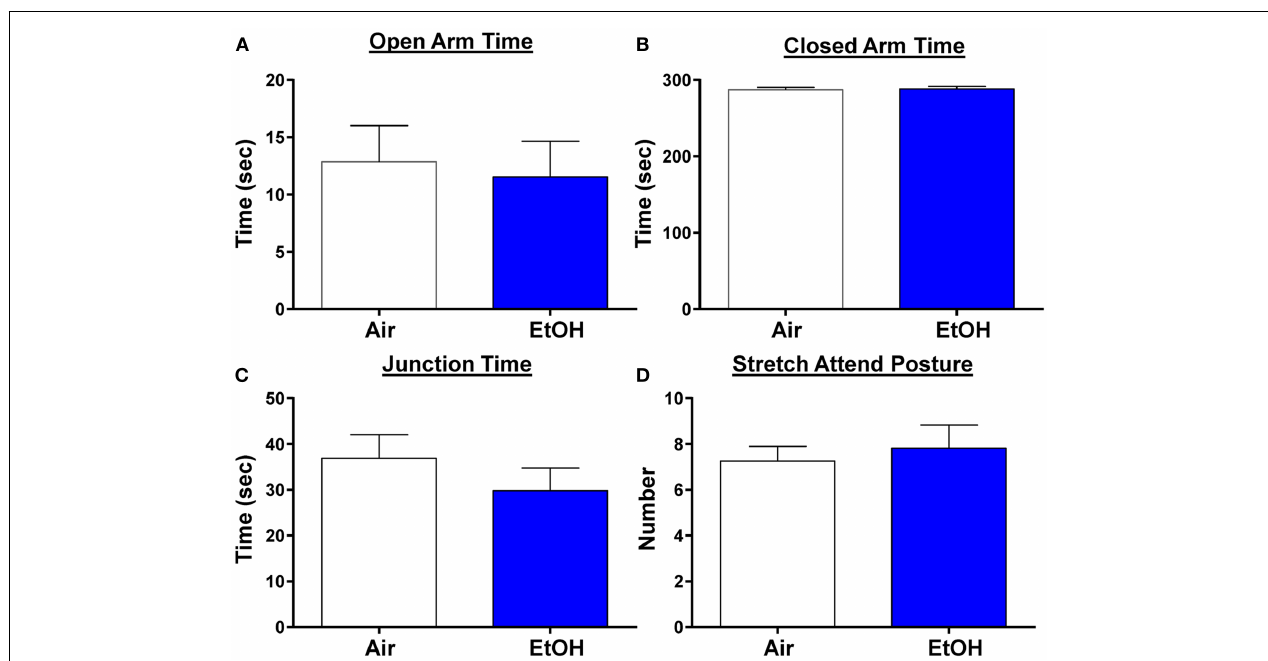
t -test), (C) junction time ( p > 0.05 by unpaired t -test), or (D) number of times animals engaged in stretch attend posture ( p > 0.05 by unpaired t -test). N = 8 animals from 3 Air litters and 11 animals from 5 EtOH